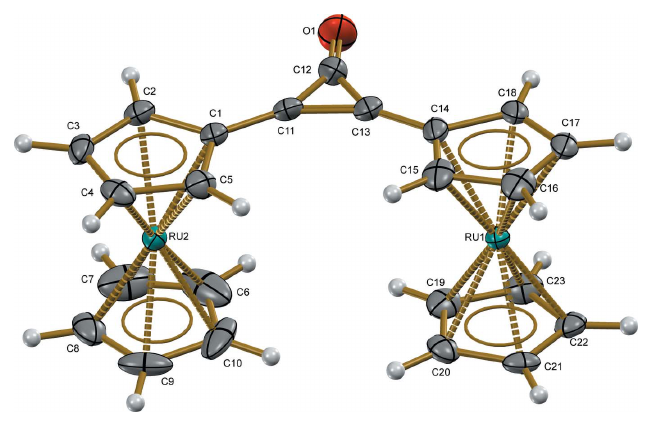
Figure 1 The molecular structure of the title compound, showing the atom labelling. Displacement ellipsoids are drawn at the 60% probability